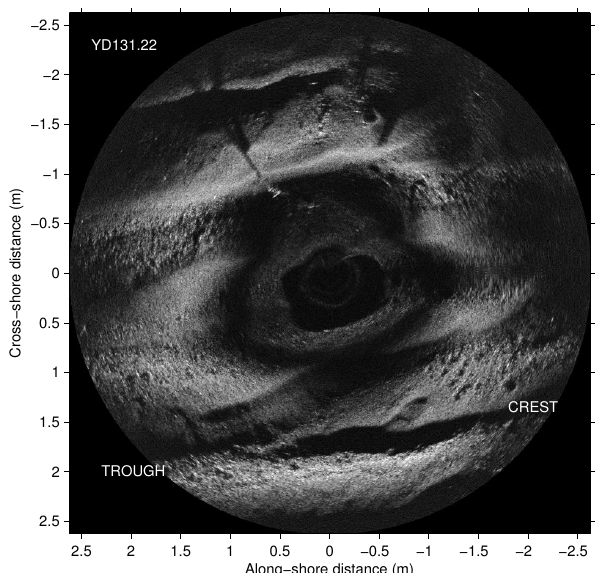
Figure 8. Rotary fan-beam sonar image, showing metre-scale wavelength ripples formed on the rising tide. Note the pronounced textural difference between ripple troughs and crests, and the cob- bles of up to 10–20cm diameter in the ripple troughs (e.g. at lower right). Lighter shades of gray correspond to higher amplitude backscatter. Cross-shore distance is positive offshore.